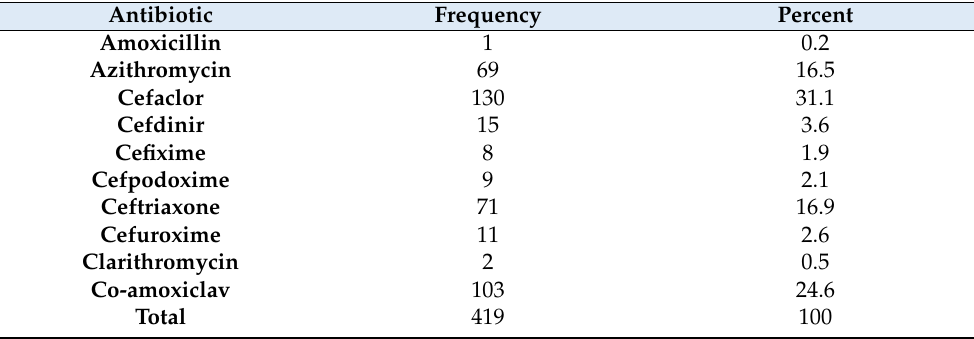
Table 3. Frequency and percentage of cases with